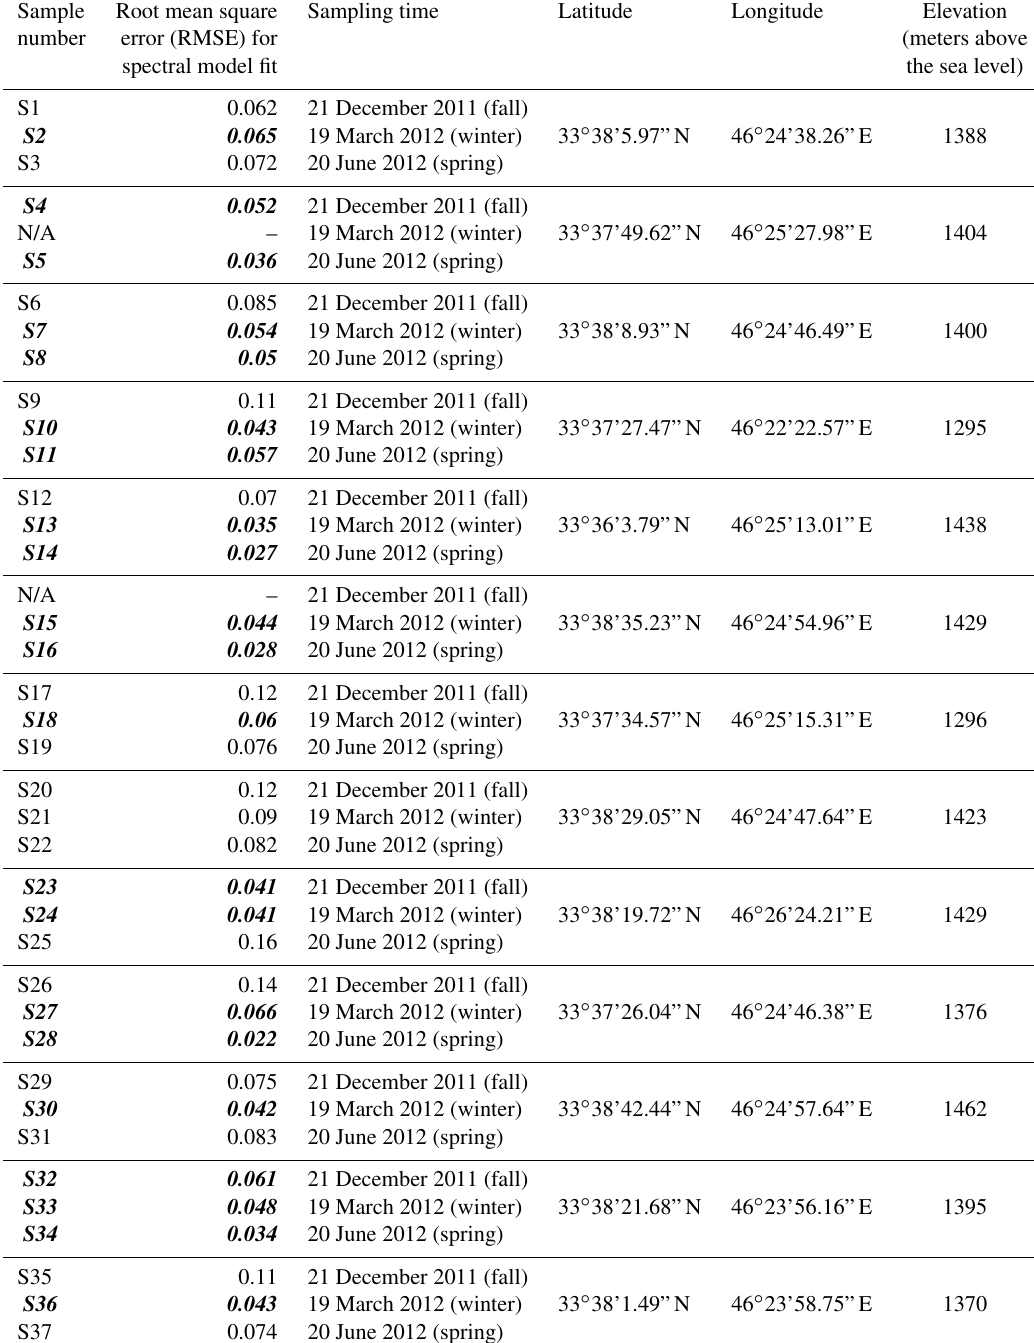
Table A1. Locality of 13 deposition samplers in Ilam. Sample numbers shown with N/A did not have enough sample volume for analysis. Root mean square errors (RMSEs) for spectral model fit are also shown. Bold and italic fonts on sample number and RMSE indicate those with a good spectral model fit as described in the text and shown with checks in Fig. 10 and Fig